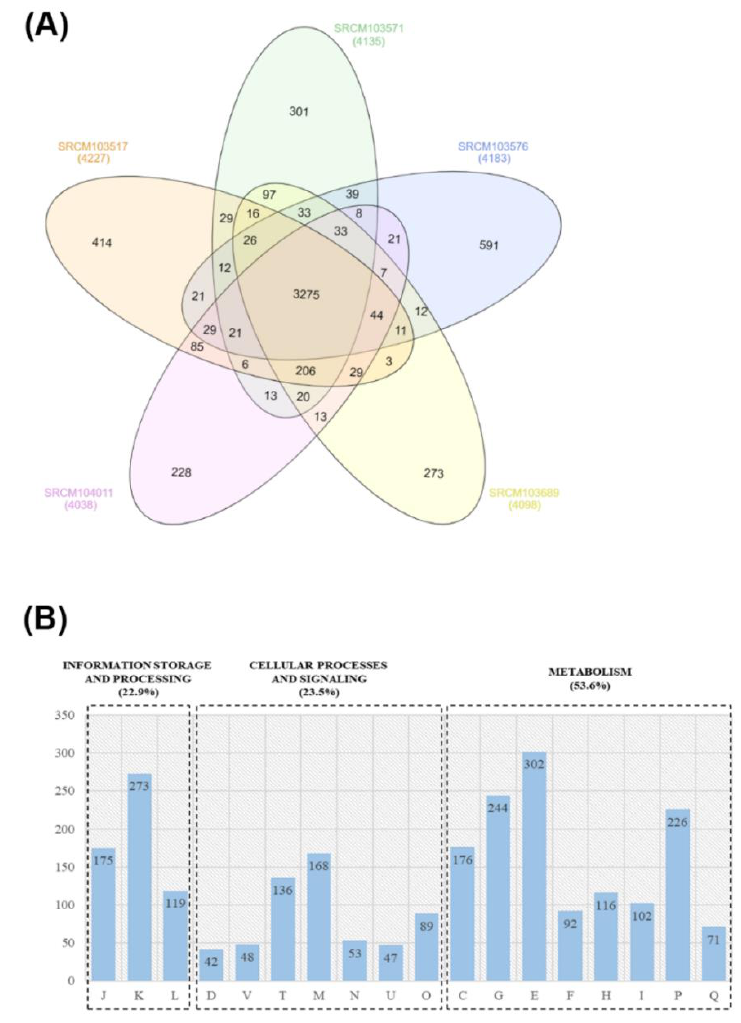
Figure 3. Venn diagram of pangenome analysis results using selected B. subtilis strains from Korean traditional fermented food. ( A ) Venn diagram of pangenome analysis results using 5 B. subtilis strains from Korea traditional fermented food. ( B ) Core genes of B. subtilis 5 strains from Korea using the COG database. J, Translation, ribosomal structure, and biogenesis; K, Transcription; L, Replication, recombination, and repair; D, Cell cycle control, cell division, and chromosome partitioning; V, Defense mechanisms; T, Signal transduction mechanisms; M, Cell wall / membrane / envelope biogenesis; N, Cell motility; O, Posttranslational modification, protein turnover, and chaperones; C, Energy production and conversion; G, Carbohydrate transport and metabolism; E, Amino acid transport and metabolism; F, Nucleotide transport and metabolism; H, Coenzyme transport and metabolism; I, Lipid transport and metabolism; P, Inorganic ion transport and metabolism; Q, Secondary metabolite biosynthesis, transport, and